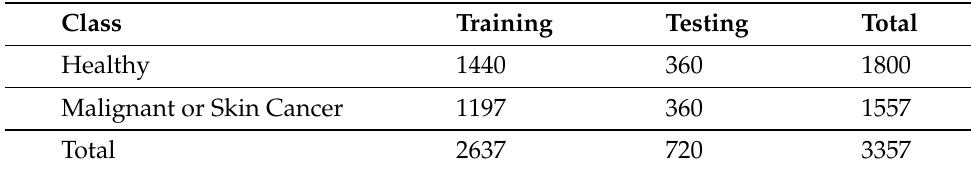
Table 2. Statistics of skin disease detection dataset.